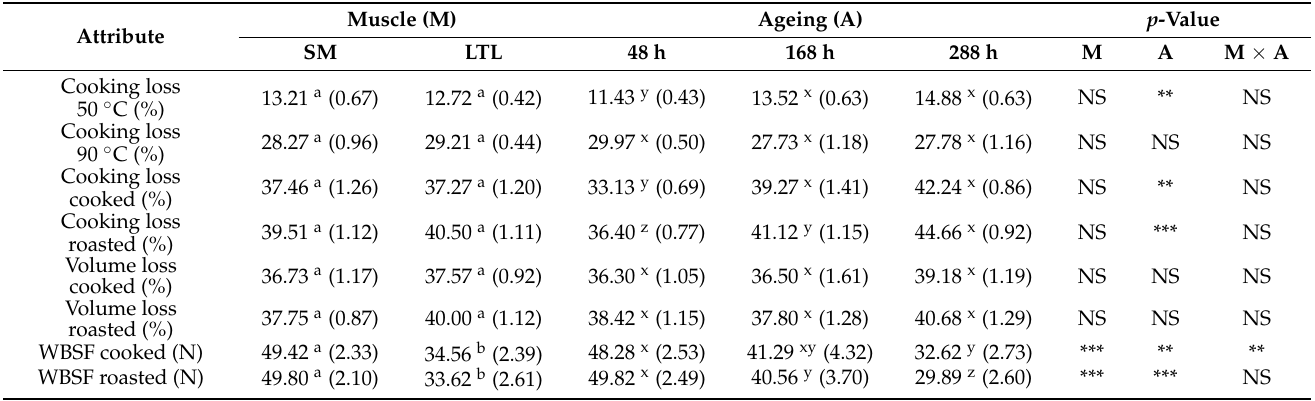
Table 2. The effect of muscle and ageing on cooking and volume losses and Warner–Bratzler shear force (WBSF) in cooked and roasted fallow deer meat (mean values and standard error of the mean in